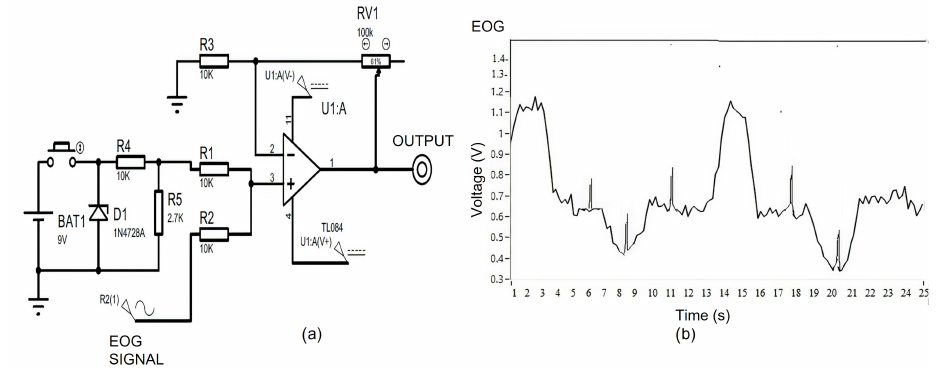
Figure 22. Experimental impulse function added to the input of the EOG acquisition system to evaluate the performance of the HMI system against disturbances. ( a ) System to test interference elimination. ( b ) Signal obtained with